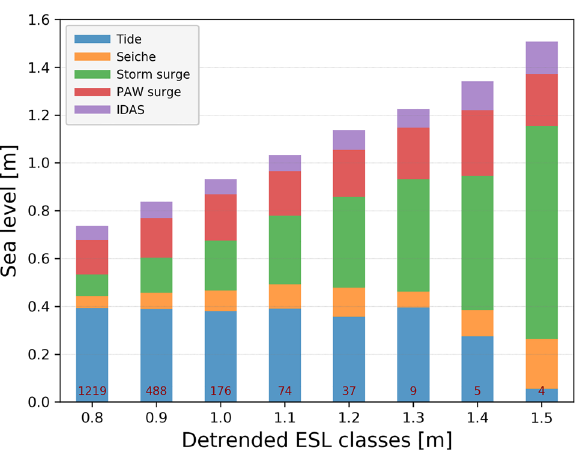
Figure 2. Mean contribution (in m) of the different drivers of ESLs subdivided into 10 cm bins. The red labels inside the bars indicate the number of events per